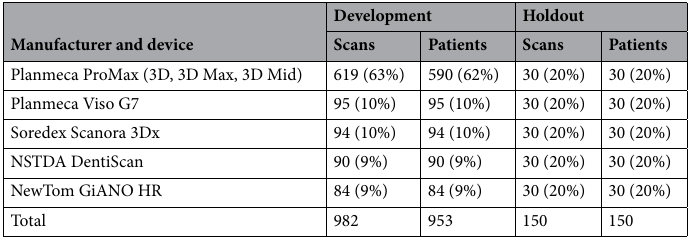
Table 2. Distribution of scans with five CBCT scanners and patients for each of the